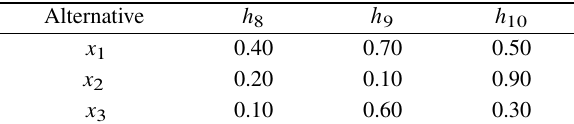
Table 6 Fuzzy soft set ( F , I 2 ).